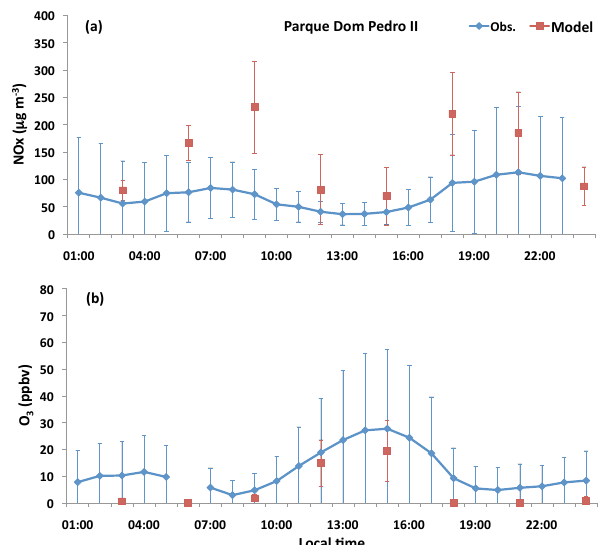
Fig. 13. Monthly (a) NO x mixing ratio (ppbv) and (b) O 3 (ppbv) from a CETESB ground station in a small city in the countryside in the state of S˜ao Paulo (Sorocaba) and from the